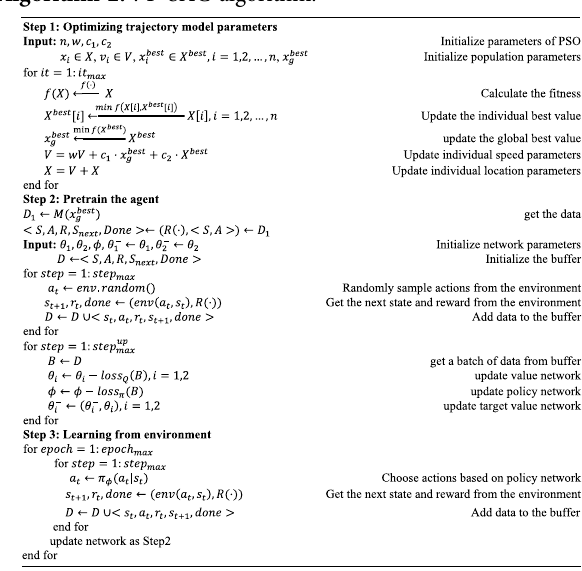
Algorithm 2. : P-SAC